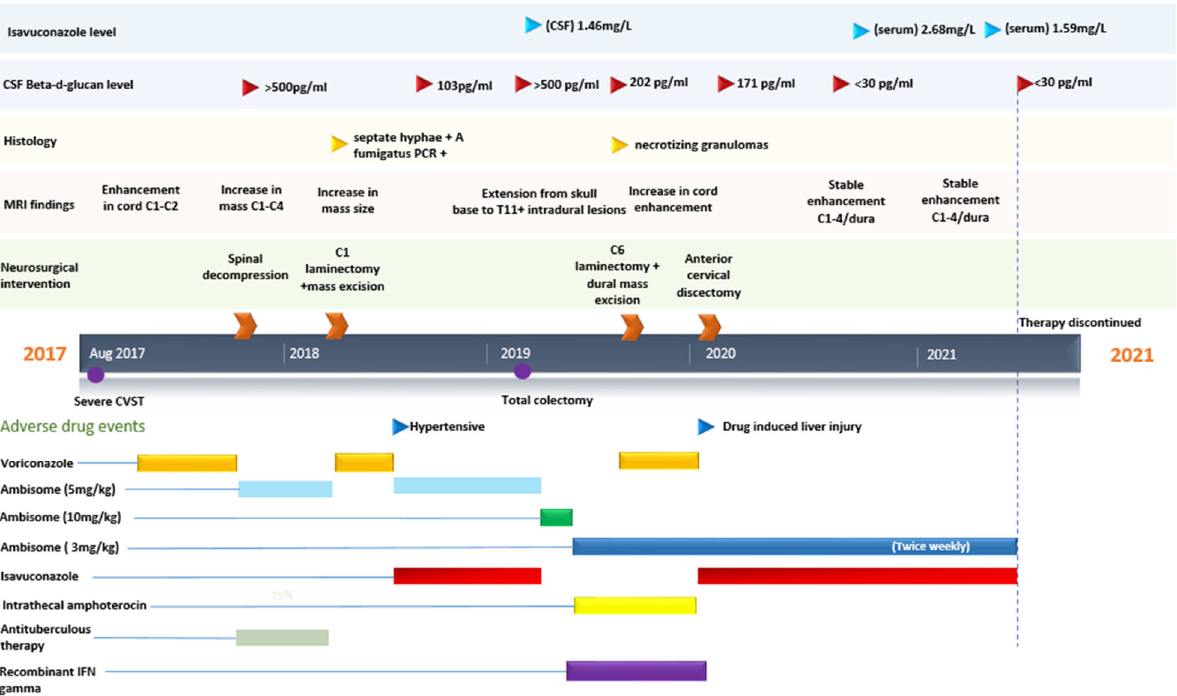
Figure 1. Timeline of major events and drug therapy.